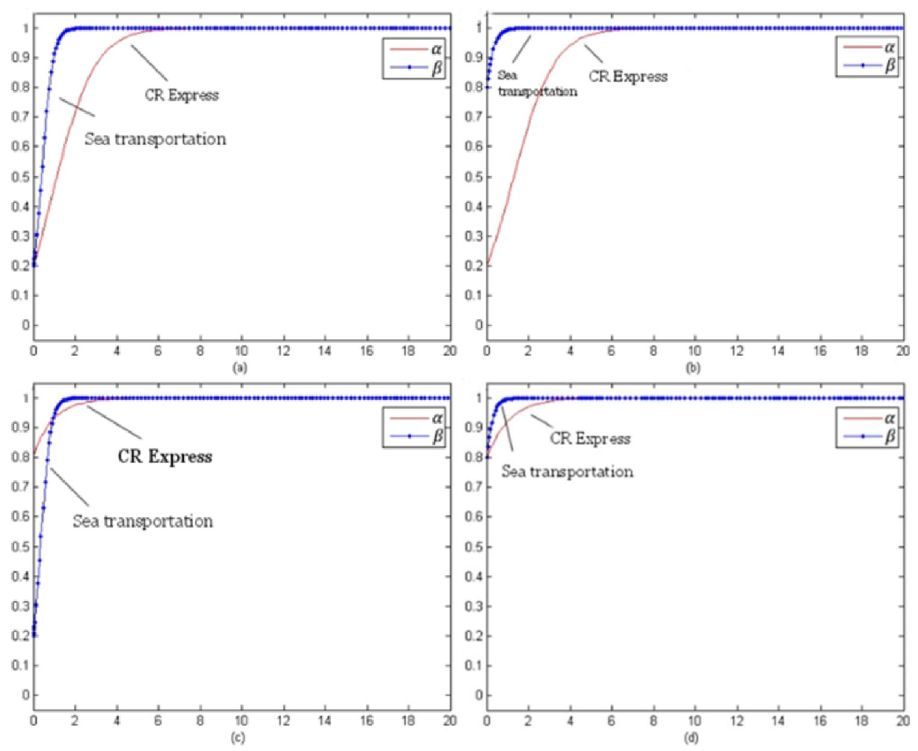
Fig 4. Game evolution trend of auto parts transportation competition (with